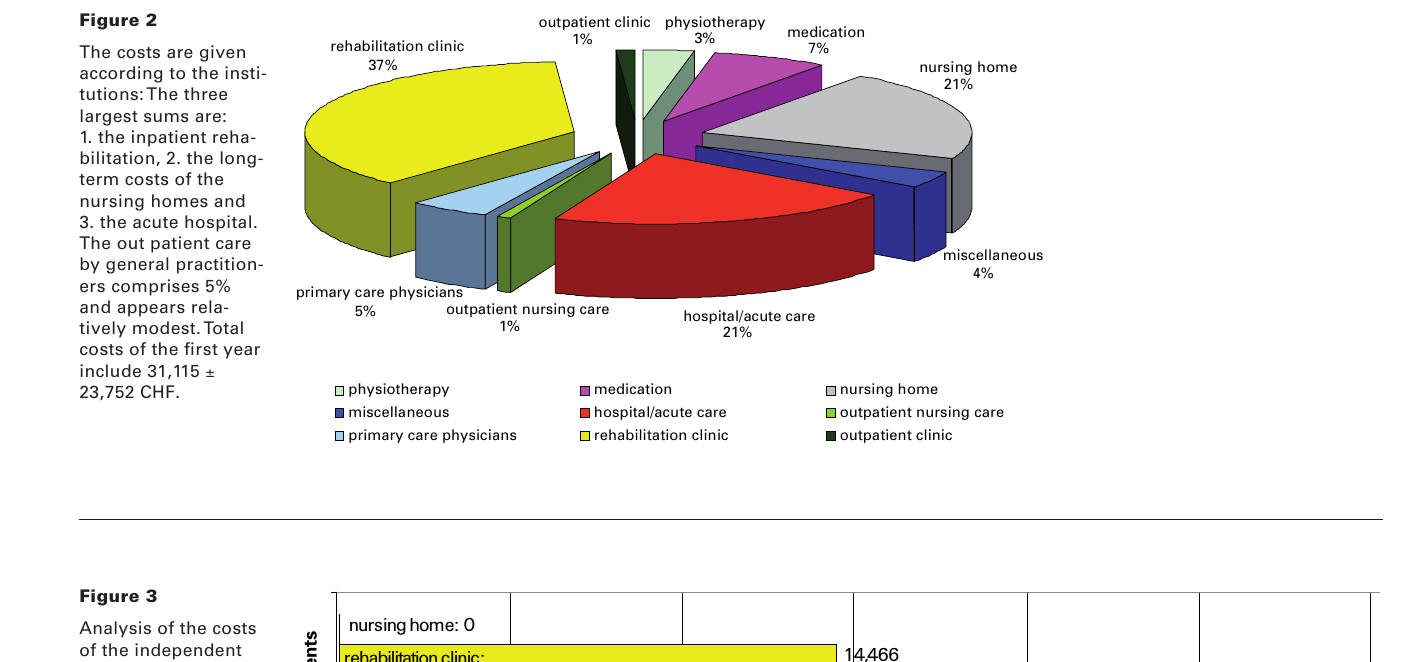
Figure 3 Analysis of the costs of the independent compared to the de- pendent patients. The figure illustrates that inpatient rehabilita- tion is the dominant factor of independ- ence in the first year, whereas the nursing home costs exceed that number by a fac- tor two in the group of the dependent patients already in the first